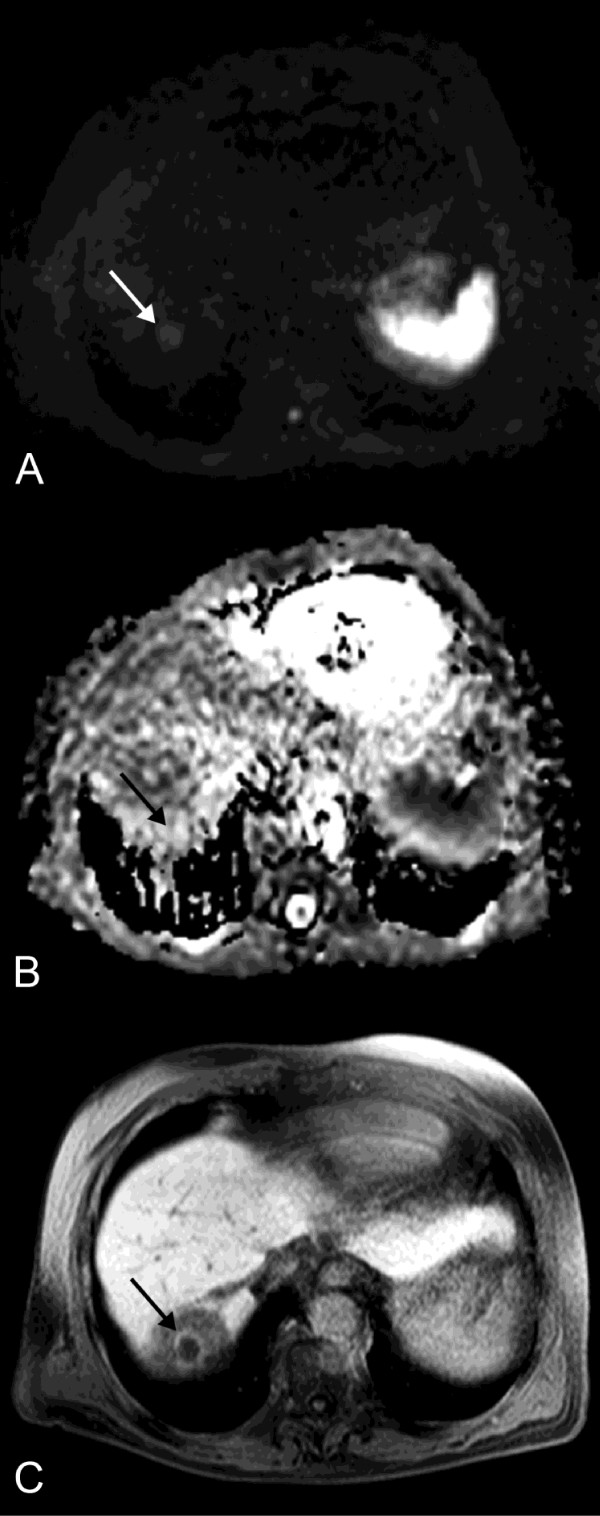
Follow-up MRI. DWI (A) and ADC map (B) performed 105 days post intervention (same patient as in Figure 1) show a rise of mean tumor ADC of 75.2% to 2.26 × 10-3 mm2s-1 (arrow). This finding correlates with a decrease in tumor volume by 90.6% (2.2 cm3), depicted in T1w Gd-EOB-DTPA enhanced MR image in hepatobiliary phase (C). The circular hypointense region around the treated lesion in (C) indicates the area of irradiation induced reversible hepatocyte dysfunction.